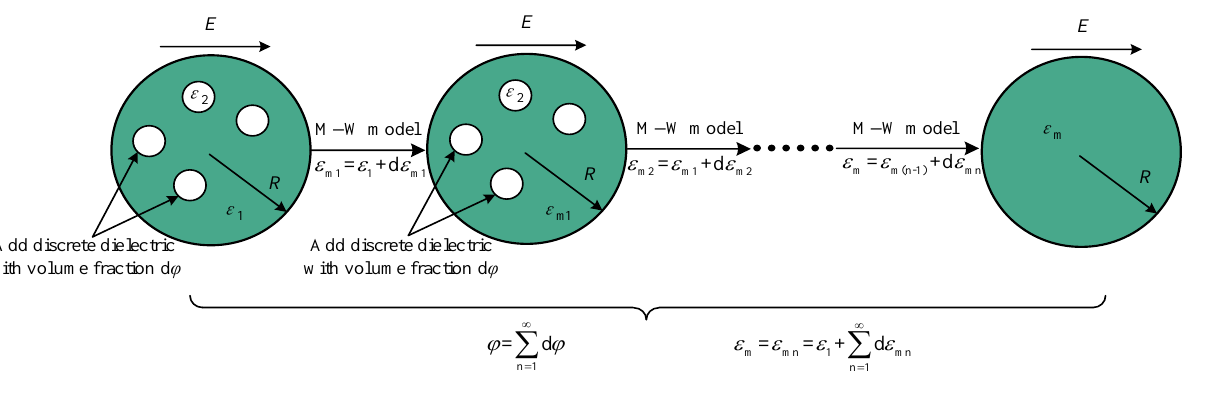
Figure 2. Integral principle diagram.